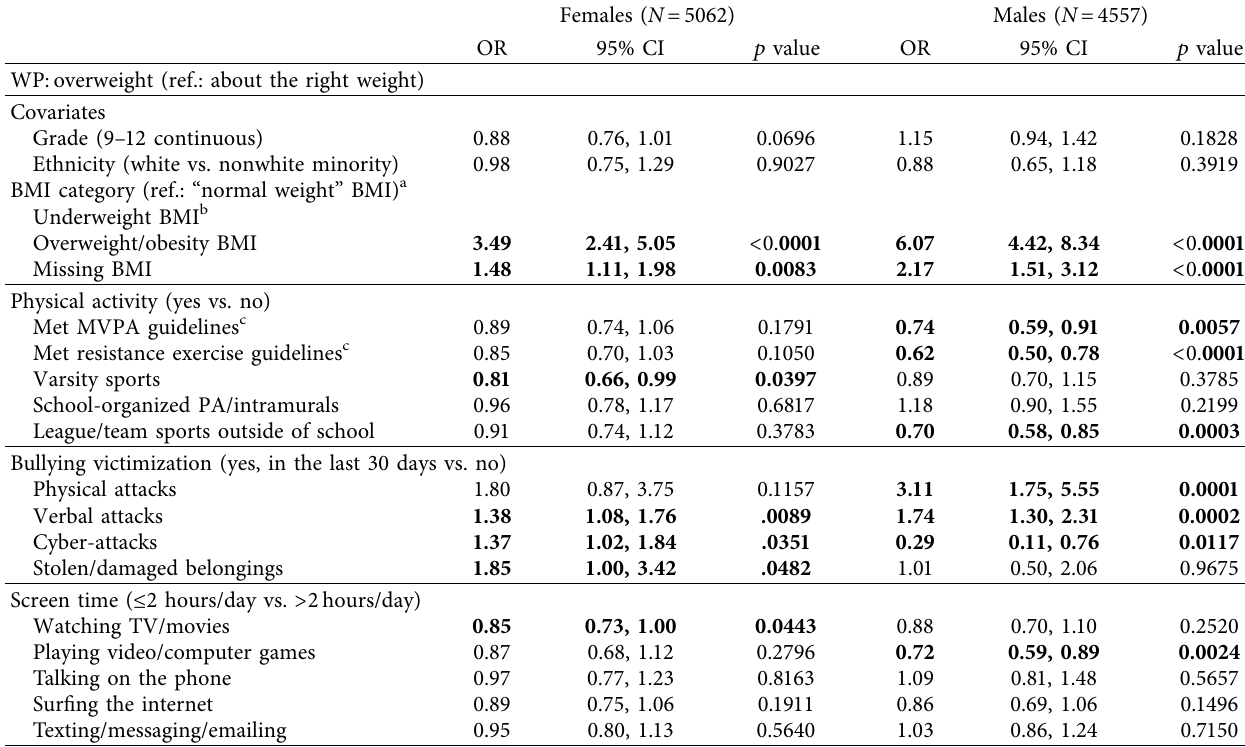
Table 4: GEE model results for predictors of youth perceiving their weight as “overweight” in Year 4 (2015/2016) of the COMPASS study among grade 9–12 students with Year 3 (2014/2015) WPs of “about the right